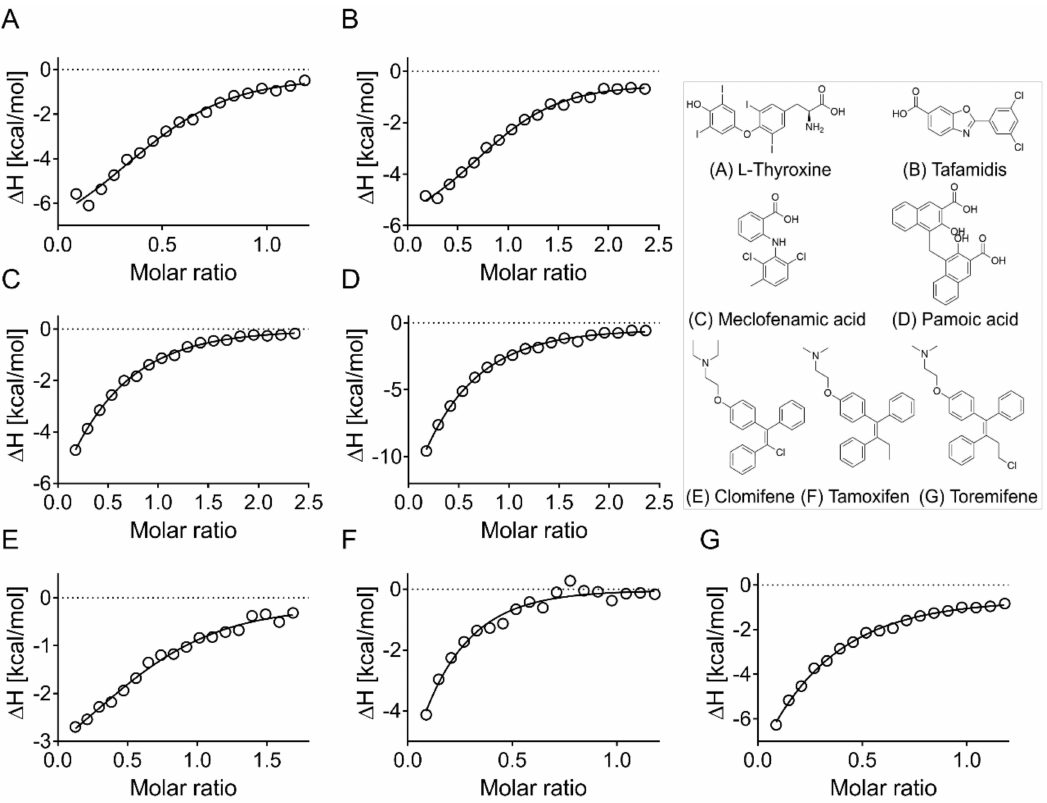
Figure 8. Hit confirmation by isothermal titration calorimetry. All eight hits confirmed by MST were tested by ITC, and six could be confirmed. Binding curves could not be fully resolved of a majority of hits due to binding affinities being in the micromolar range. Binding to ApoE4 was confirmed for ( A ) L -thyroxine, ( B ) its compound analog tafamidis, ( C ) meclofenamic acid, ( D ) pamoic acid, ( E ) clomifene, ( F ) tamoxifen, and ( G ) toremifene. Isotherms of raw titration are shown in Supplementary Figure S5. Figures show the normalized binding heats, with the solid line representing nonlinear least-square fits using the single-site binding